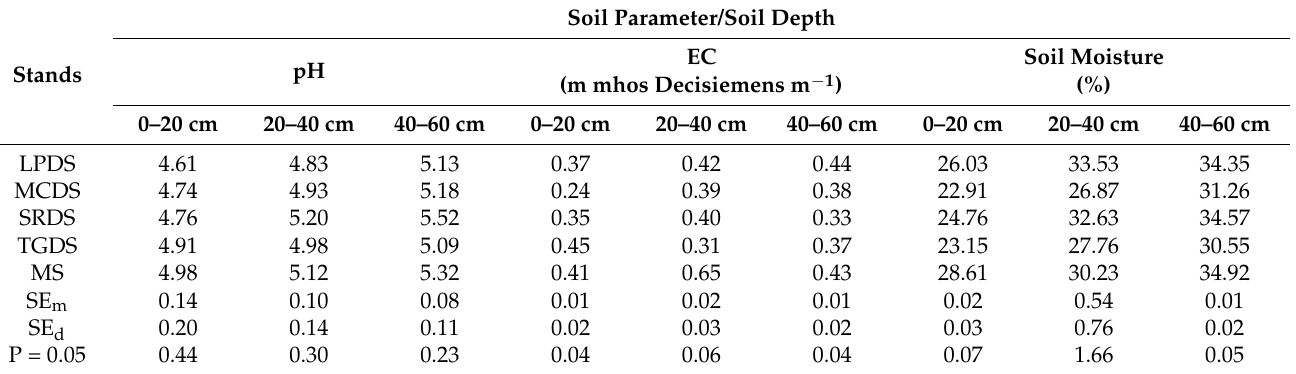
Table 2. Soil pH, EC and moisture in different